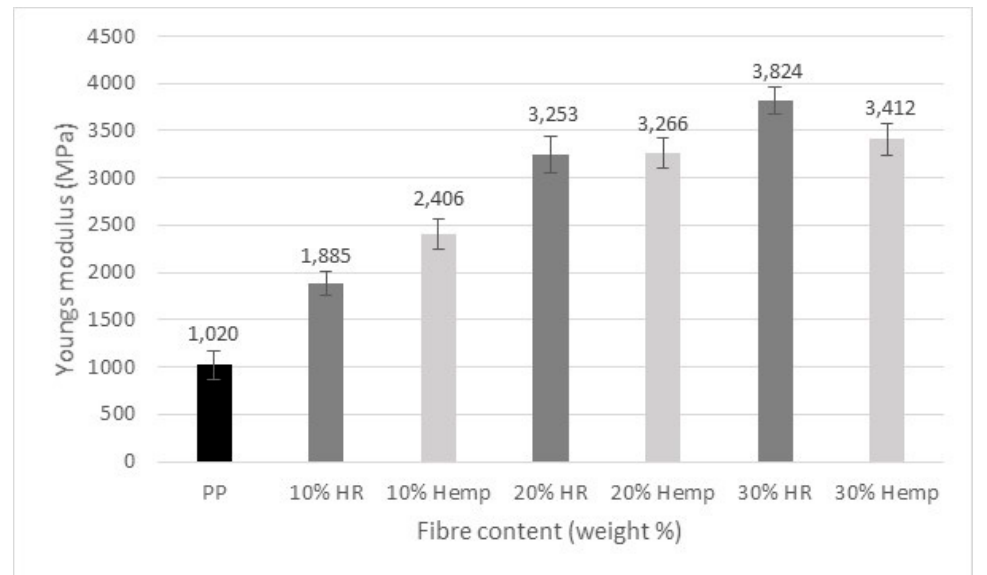
Figure 6. Tensile strength of 3 mm printing filament with natural fibre.